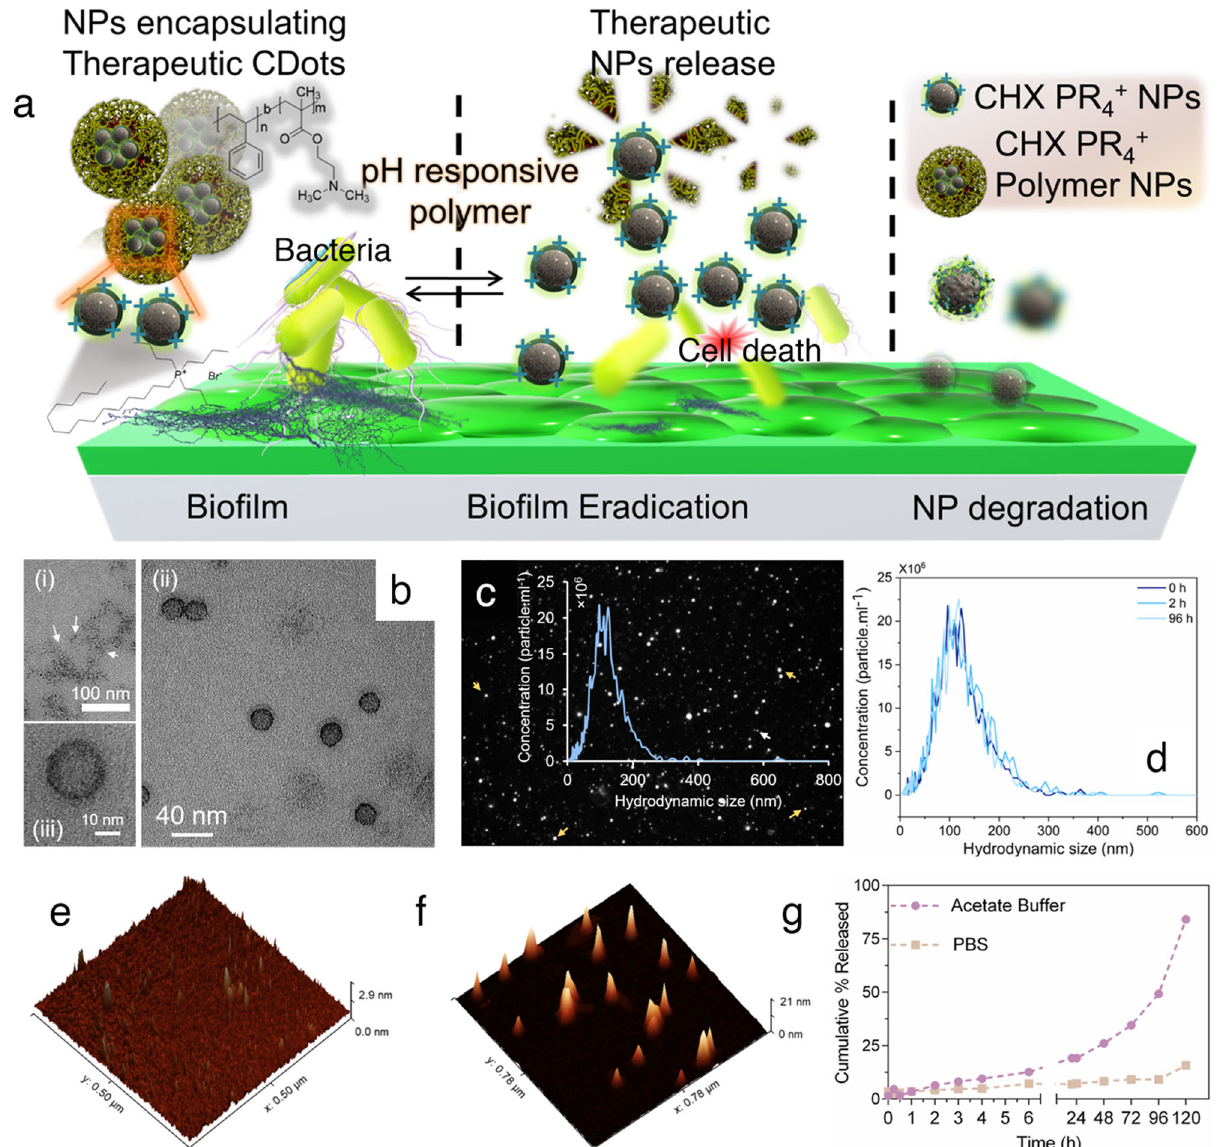
Fig. 1 Design and characterization of nanoparticles. a Schematic representation of the action of NPs as antibio fi lm agents. The inherently antibio fi lm CDots functionalized with phosphonium ions were encapsulated in a pH-responsive diblock copolymer. At low pH, the shell will open to release the therapeutic load leading to the eradication of the dental bio fi lm, the zoomed region represents the wrapping of smaller CDots in the diblock copolymer, the NP degradation is represented as faded particles; b transmission electron microscopic image of (i) bare CHX PR 4 + NPs, (ii) and (iii) polymer-wrapped CDots (CHX PR 4 + polymer NPs); c Hydrodynamic distribution of CHX PR 4 + polymer NPs measured by ZetaView, arrows point to NPs; d hydrodynamic size stability over time; AFM height variation e before and f after wrapping the CHX PR 4 + NPs in the polymer; g pH-dependent release pro fi